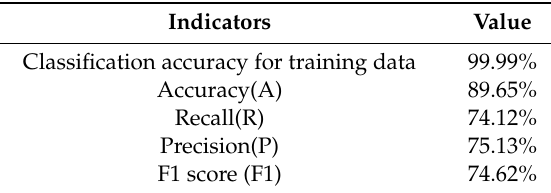
Table 10. Results of algorithm performance evaluation at single image level: indicators.